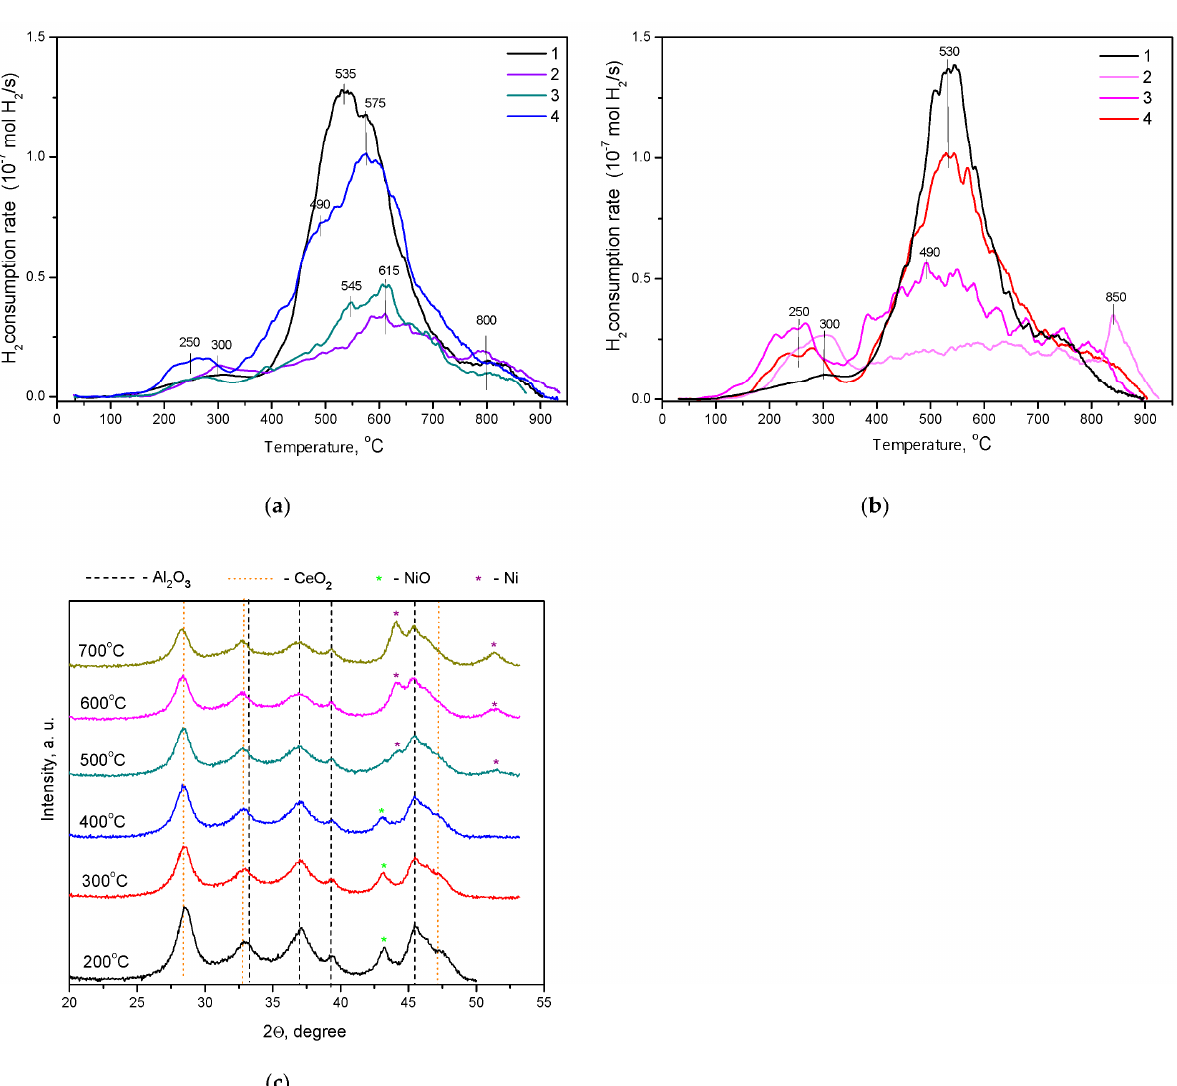
Figure 6. Reduction behavior of catalysts. TPR with hydrogen for catalysts from CI- ( a ) and SG-series ( b ) and XRD patterns of 20Ce 0.2 Ni 0.8 O 1.2 /Al 2 O 3 -CI catalyst during the reduction ( c ). ( a ) 10Ni/Al 2 O 3 - CI (1), 5Ce 0.2 Ni 0.8 O 1.2 /Al 2 O 3 -CI (2), 10Ce 0.2 Ni 0.8 O 1.2 /Al 2 O 3 -CI (3), and 20Ce 0.2 Ni 0.8 O 1.2 /Al 2 O 3 -CI (4). ( b ) 10Ni/Al 2 O 3 -SG (1), 20Ce 0.8 Ni 0.2 O 1.8 /Al 2 O 3 -SG (2), 20Ce 0.5 Ni 0.5 O 1.5 /Al 2 O 3 -SG (3), and 20Ce 0.2 Ni 0.8 O 1.2 /Al 2 O 3 -SG